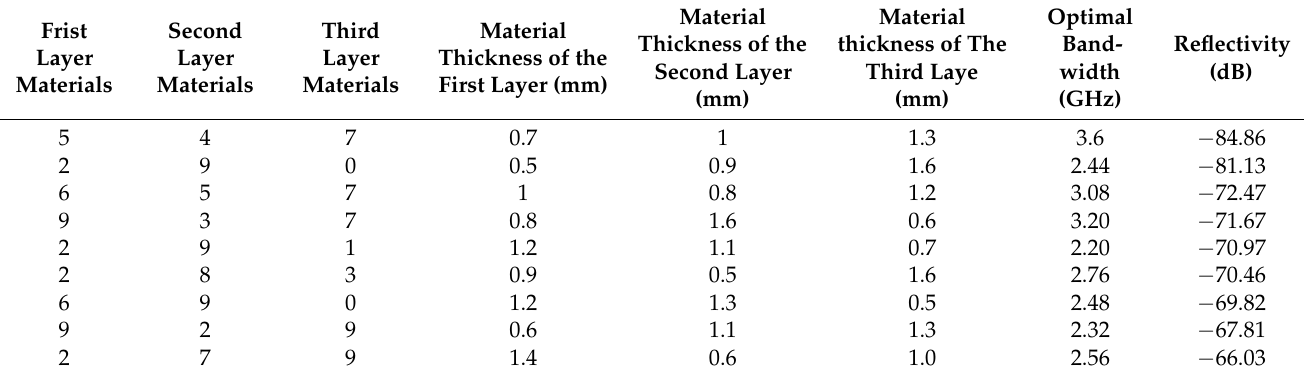
Table 5. The optimization results using objective function F2 (three-layers) of GA